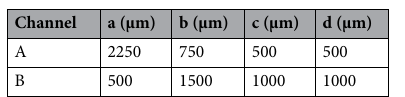
Table 1. The dimension of the cavitated